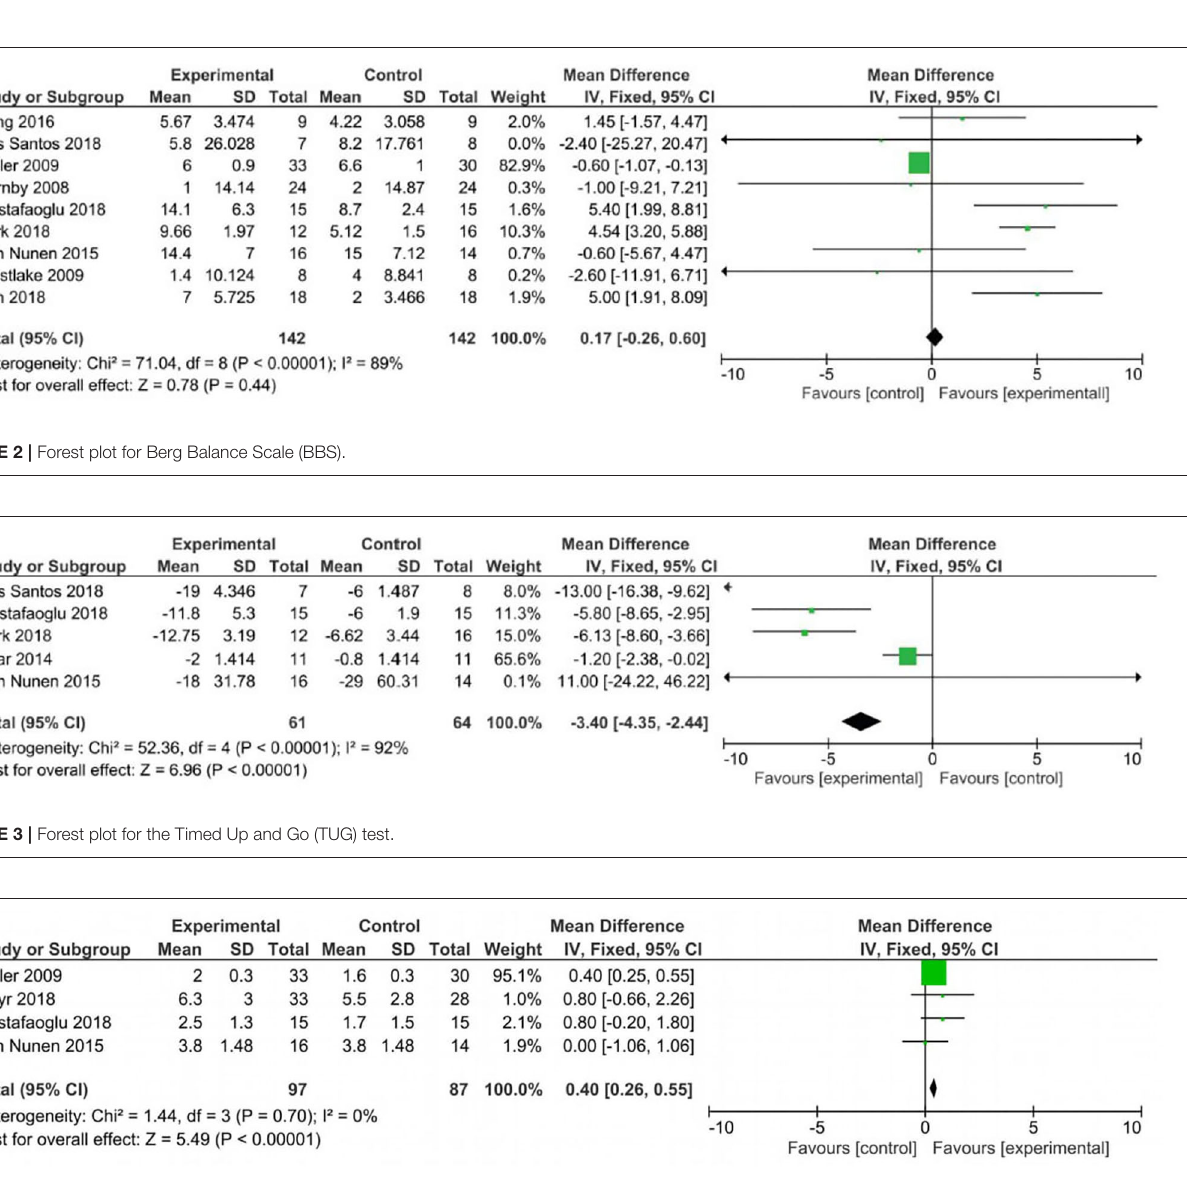
FIGURE 4 | Forest plot for Rivermead Mobility Index